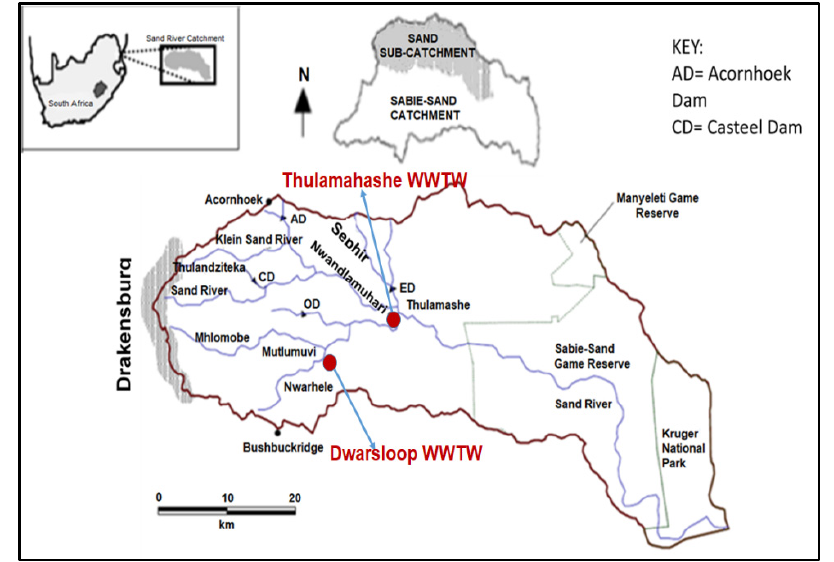
Figure 1. Sand River Catchment and Location of the Dwarsloop and Thulamashe WWTWs.